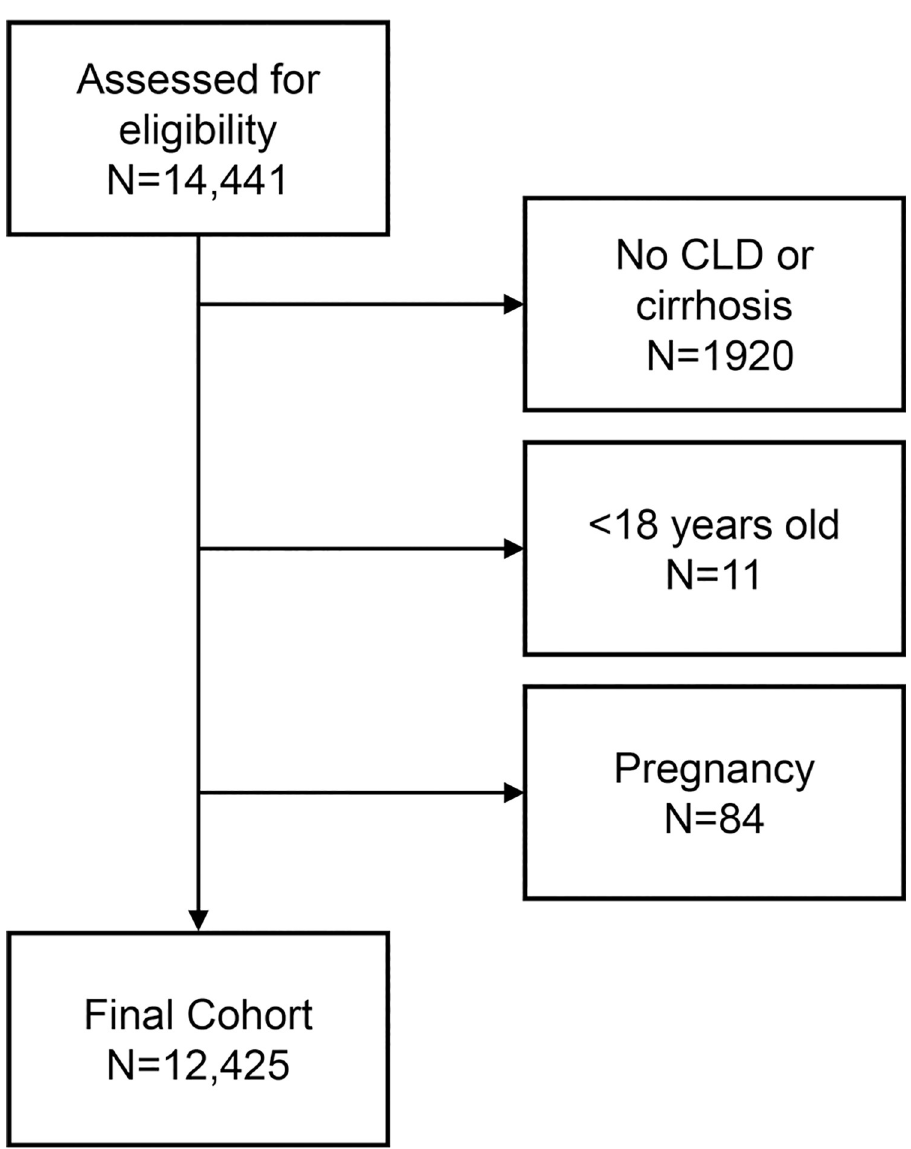
Fig 1. Cohort of patients with chronic liver